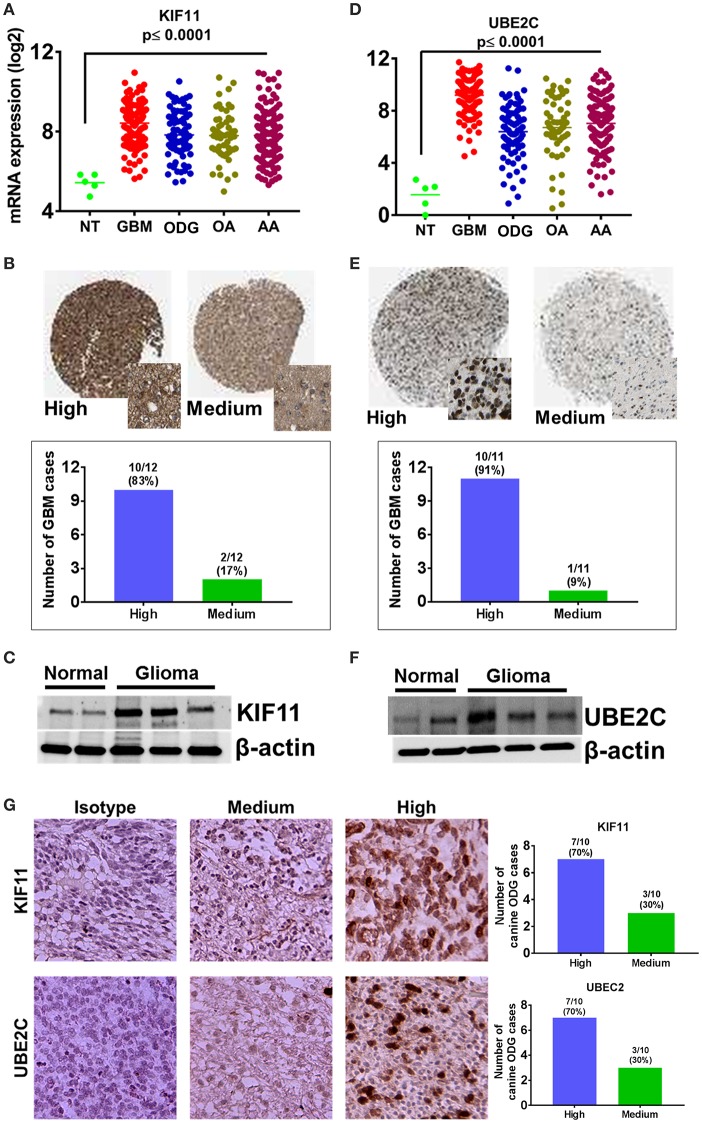
Overexpression of cell cycle regulators KIF-11 and UBE2C in human and canine glioma. (A) Overexpression of KIF-11 mRNA (TCGA data) in human GBM, ODG, OA, and AA tumors. (B) KIF-11 protein levels were upregulated in human GBM (Human Protein Atlas). (C) Western blot analysis showed the overexpression of KIF-11 in canine ODG compared to normal brain. (D) UBE2C mRNA overexpression (TCGA data) in human GBM, ODG, OA, and AA tumors. (E) UBE2C protein levels were overexpressed in human GBM (Human Protein Atlas). (F) Western blot analysis showed the overexpression of UBE2C in canine ODG as compared to normal brain. (G) IHC analysis of KIF-11 and UBE2C in canine ODG cases (n = 10). Specific staining intensity was classified as high with strong signal with 100% cells positivity and medium as moderate to strong signal with 60–80 percent cells positivity. Quantification of high and medium expression cases were performed and presented as percent cases.